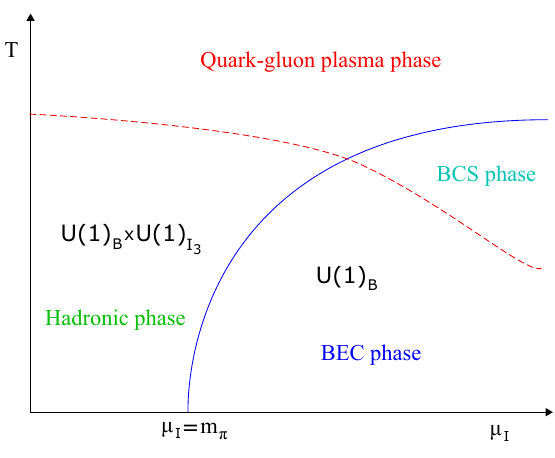
Figure 2. Phase diagram of QCD in the μ I – T